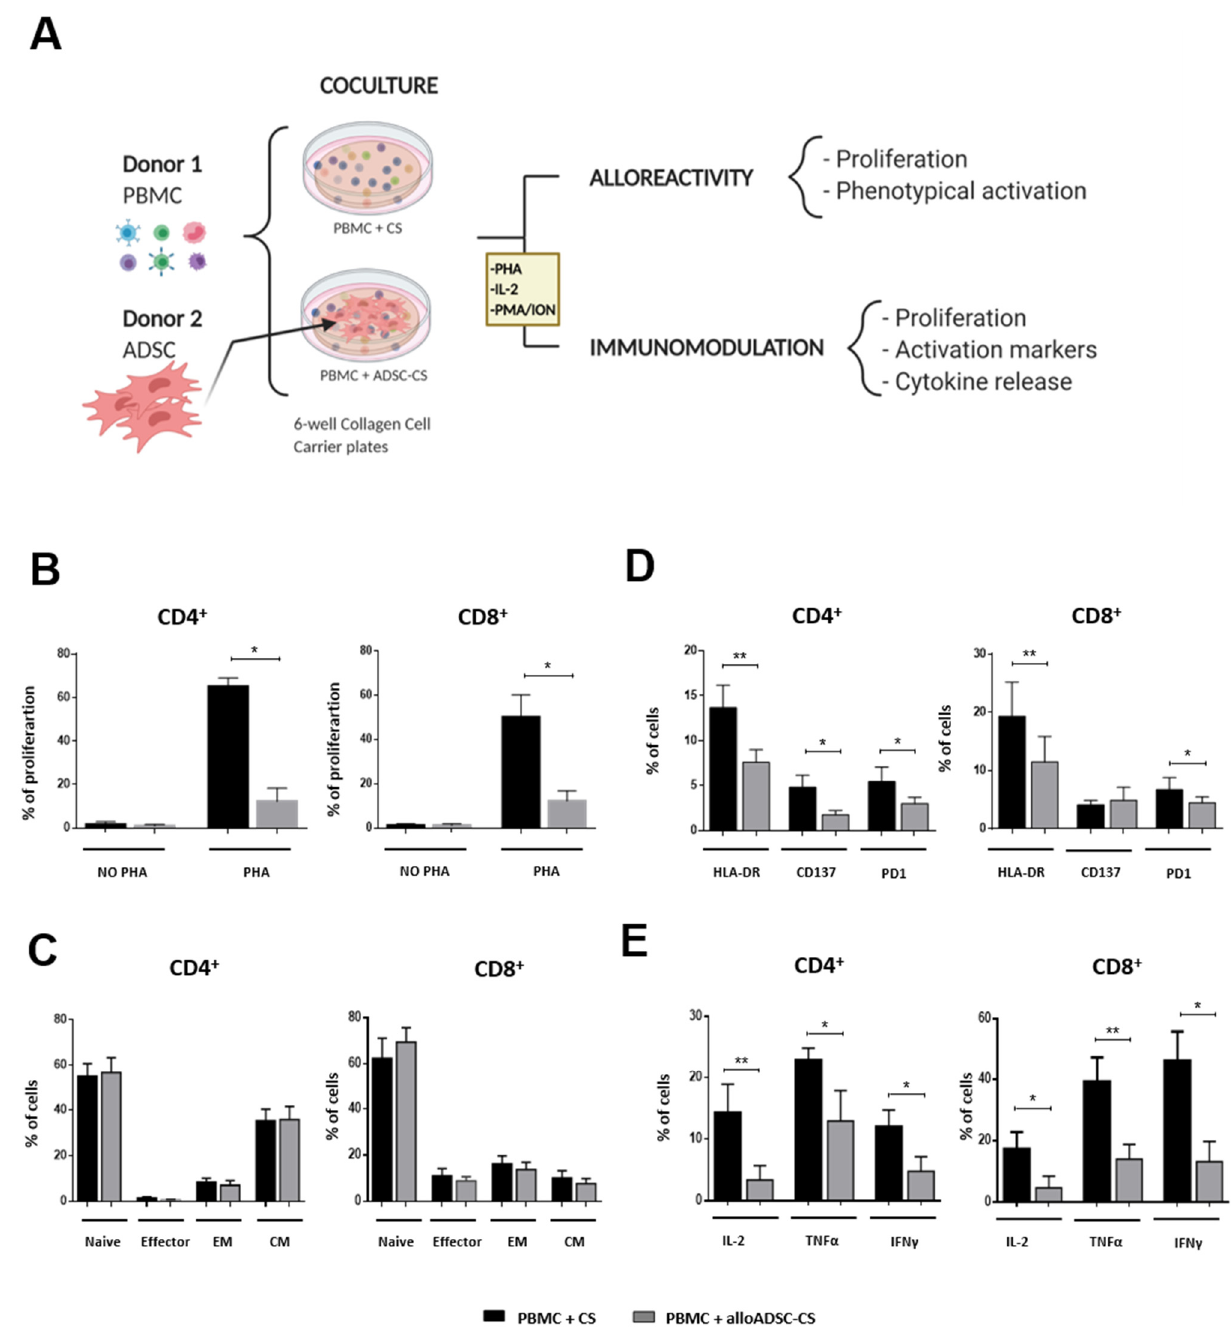
Figure 3. In vitro assessment of alloADSC-CS alloreactivity and immunomodulation. ( A ) Experimental study design. Hu- man PBMCs were cocultured with only CS or CS previously seeded with human allogeneic ADSCs for 96 h. Subsequently, lymphocyte proliferation rate, activation, and differentiation were determined by flow cytometry. ( B ) The percentage of proliferating CFSE-labeled lymphocytes (stimulated with 1 µg/mL PHA or unstimulated) in the presence of alloADSC-CS or CS. ( C ) The percentage of lymphocyte phenotypical differentiation into naive, effector, effector memory (EM), or central memory (CM) cells in the total number of CD4 + or CD8 + cells after coculturing with alloADSC-CS. ( D ) The quantification of HLA-DR, CD137, and PD1 activation markers (% of cells) in the CD4 + and CD8 + subpopulations after incubation with 300 IU/mL IL-2 and coculturing with alloADSC-CS or CS. ( E ) The production of proinflammatory cytokines, IL-2, TNF α , and IFN γ by CD4 + or CD8 + lymphocytes after activation with 0.5 µg/mL PMA and 1 µg/mL ionomycin and coculturing with alloADSC-CS or CS. The data were obtained from five or six independent experiments. The results are expressed as mean ± SEM. * p < 0.05; ** p < 0.01 (ratio paired t -test).